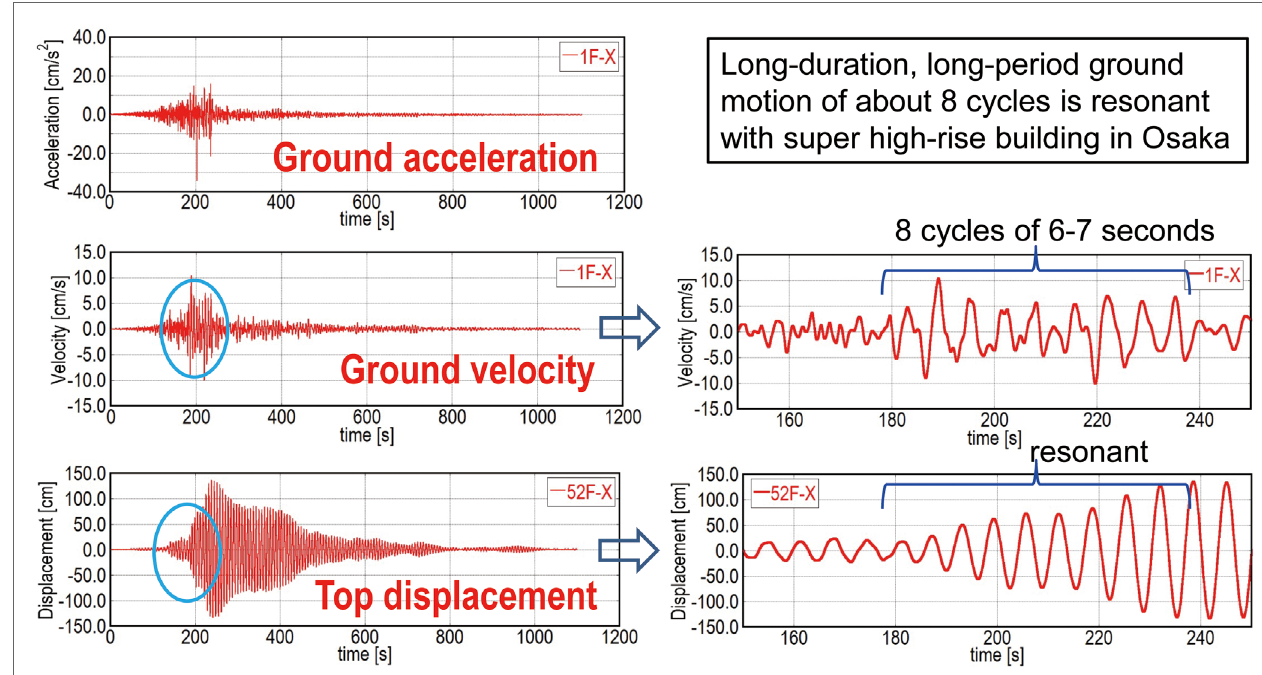
FigUre 1 | resonant response of a super high-rise building in Osaka, Japan, during the 2011 off the Pacific coast of Tohoku earthquake under long-duration, long-period ground motion (Takewaki et al., 2011, 2012)